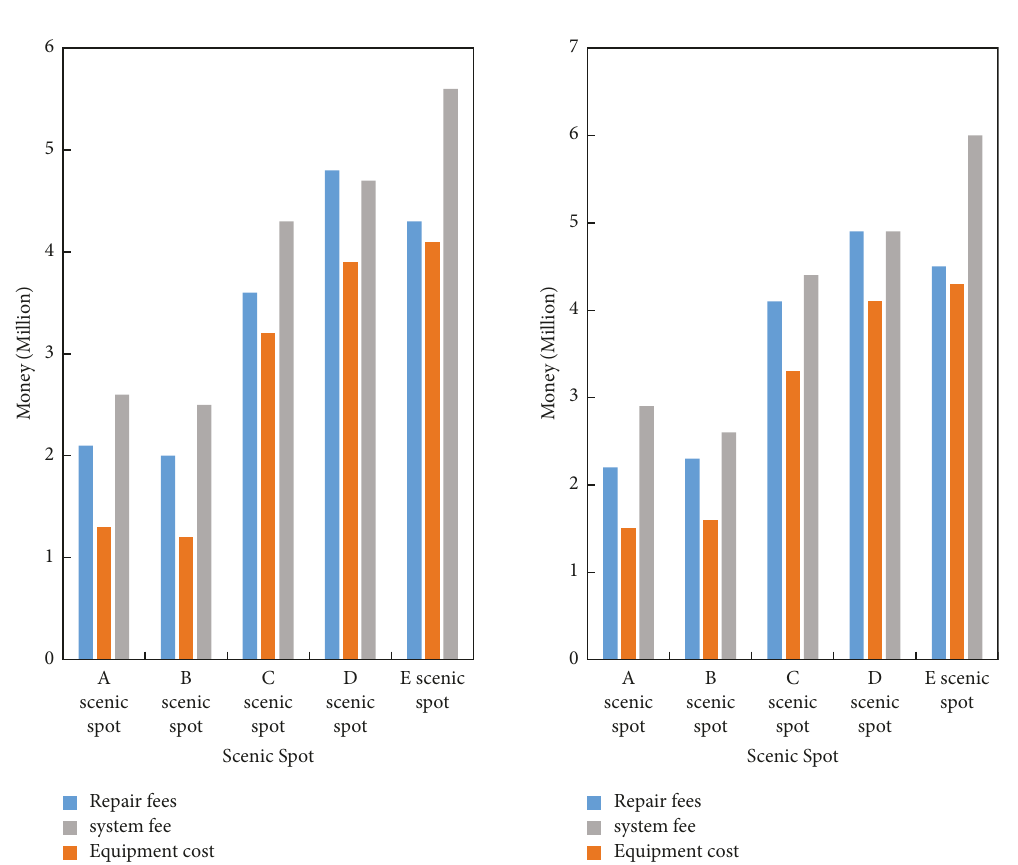
Figure 5: Graph of the test results of the number of tourists.